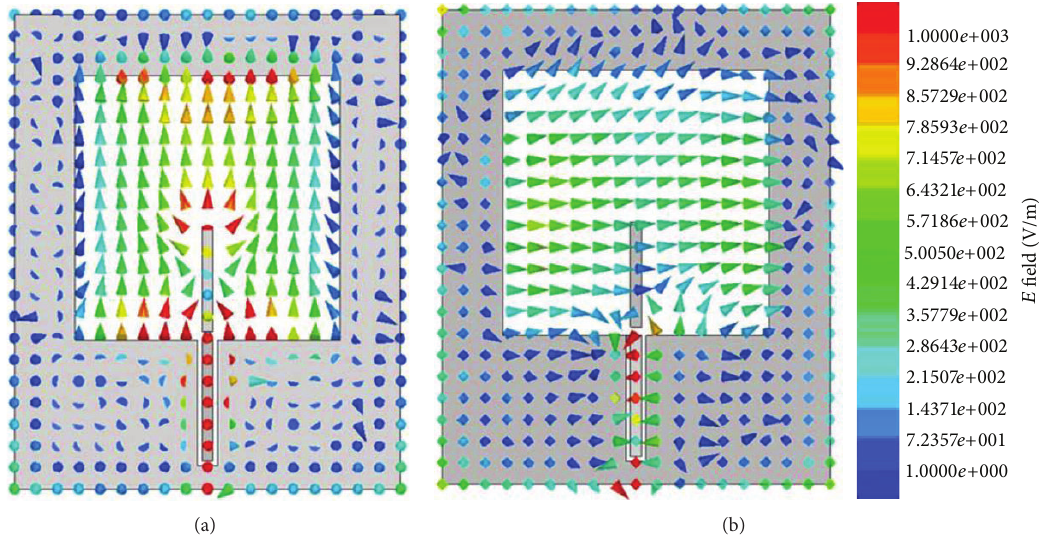
Figure 14: Electric field distribution within the reconfigurable slot antenna: (a) CPW mode; (b) slot-line mode [22].